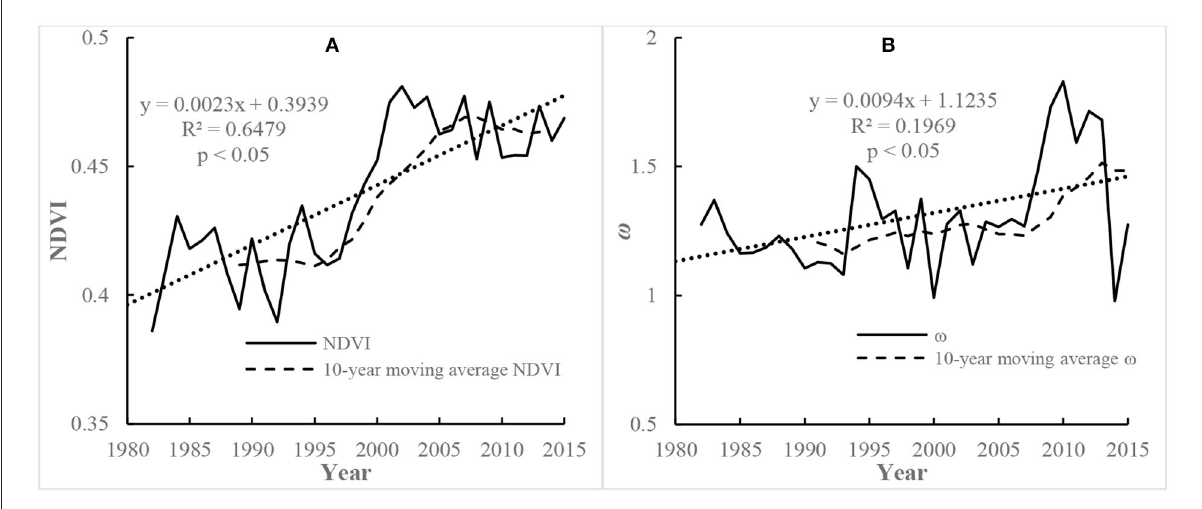
FIGURE4 (A, B) Change trend of Normalized Difference Vegetation Index (NDVI) and Budyko parameter ( ω ) in the Lancang River Basin (LCRB) from 1982 to